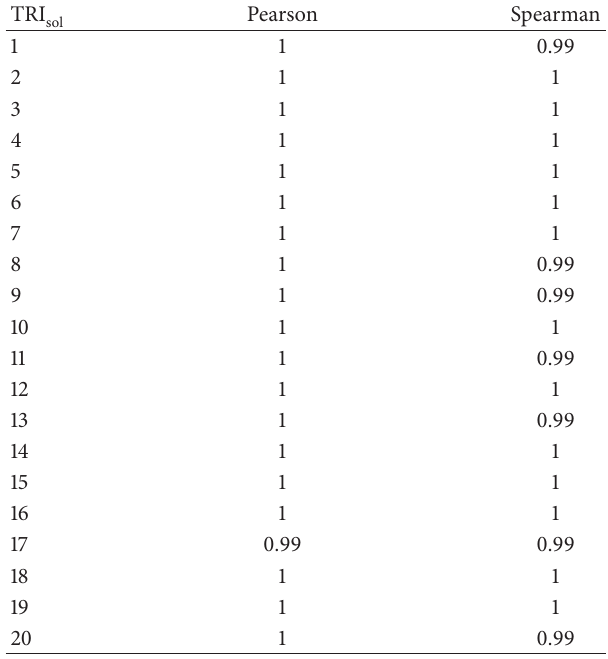
Table 7: Correlation results for tricluster Mouse GDS4510